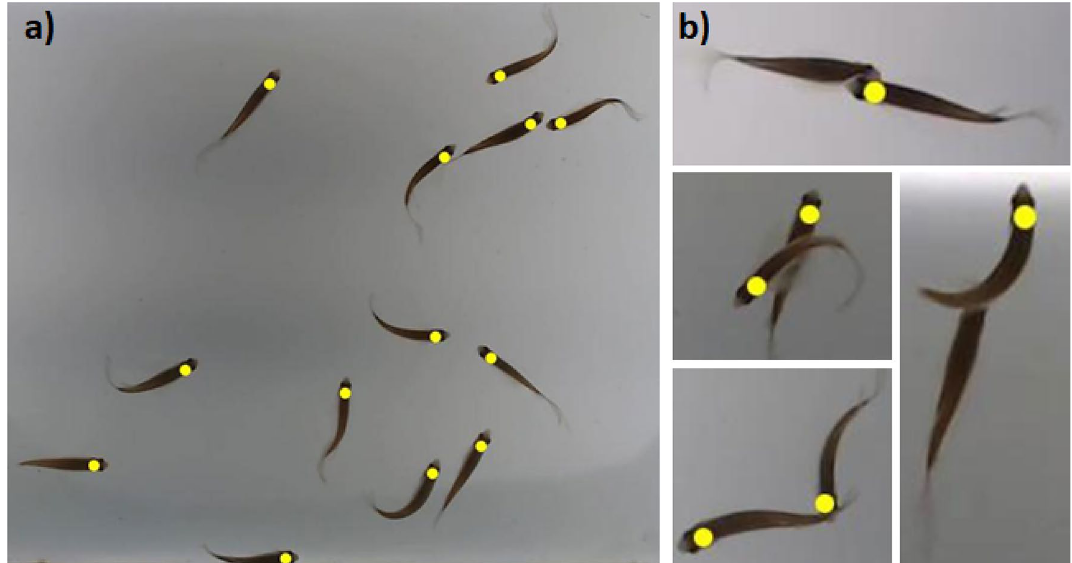
Figure 7. Fish detection. (a) Image of the complete detection of the fish head region for a group of 13 fish; (b) Examples of fish occlusion events, in some cases, there was a failure in